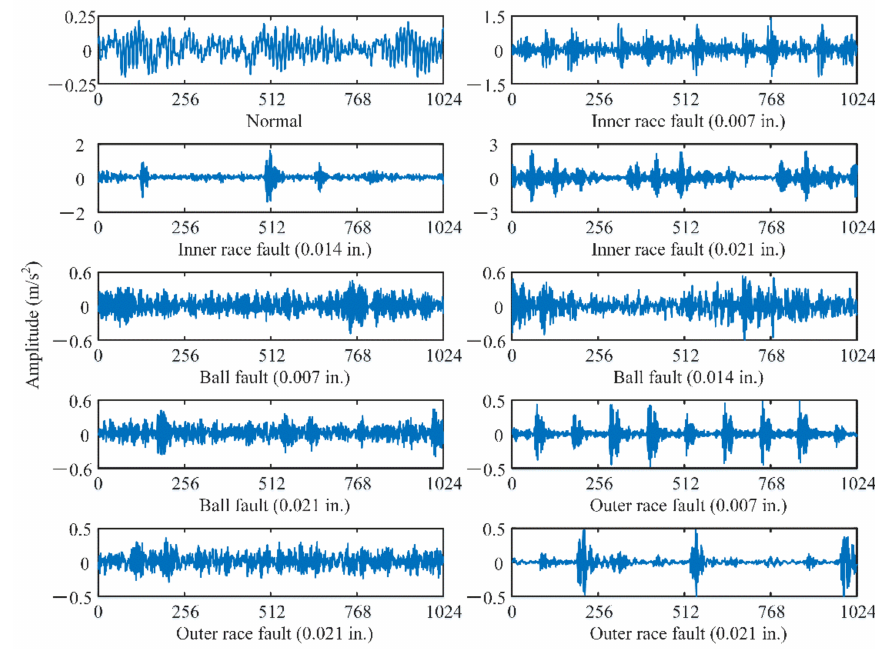
Figure 6. Data sample of bearing under one normal and nine faulty